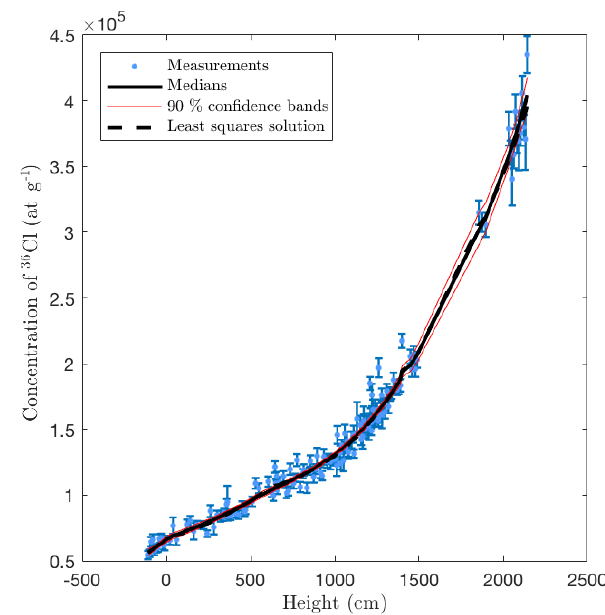
Figure 10. Fiamignano fault: measured and sampled 36 Cl concen-